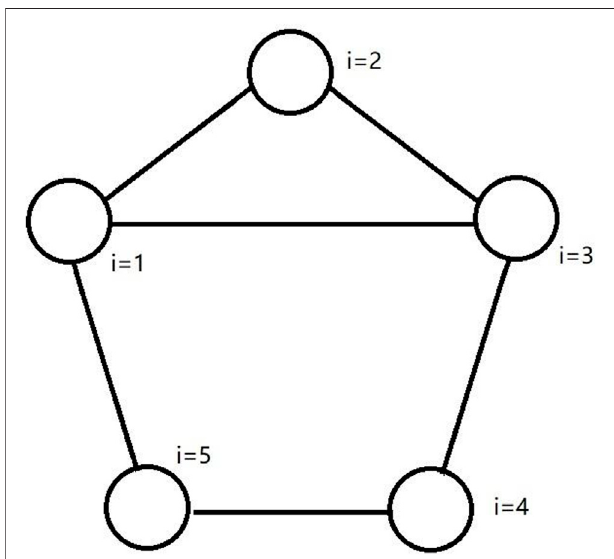
FIGURE 13 | Energy Internet